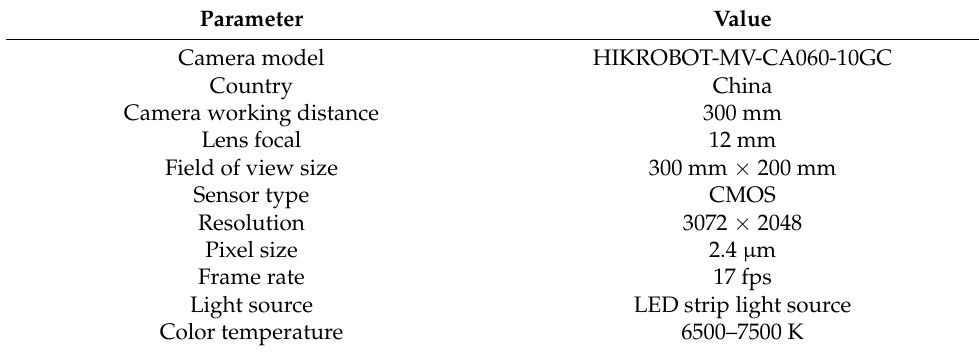
Table 1. Principal parameters of the vision acquisition system.